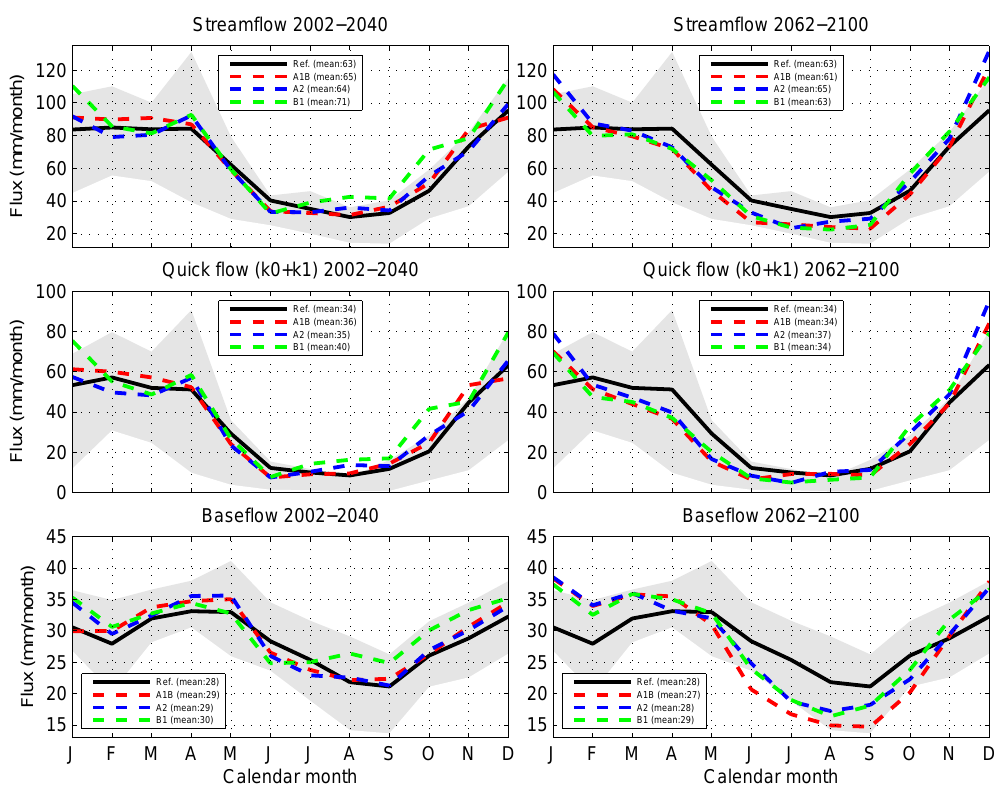
Fig. 6. Mean monthly sums of streamflow, quick flow from the upper zone and baseflow from the lower zone for the reference period and the climate scenarios, shown for the period 2002–2040 (left) and the period 2062–2100 (right). The range between the 25th and 75th percentile of the reference period is plotted as a light gray shaded